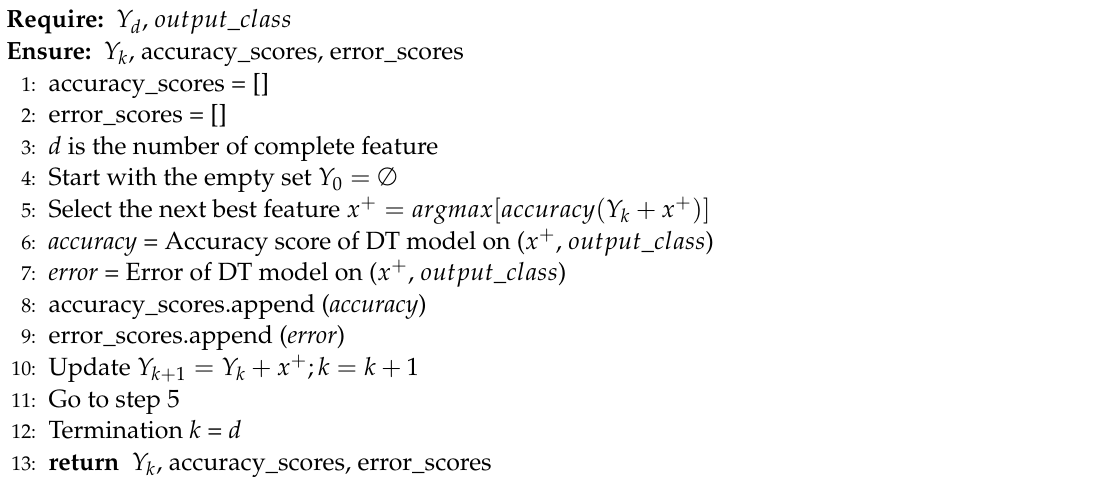
Algorithm 1 The pseudocode of the proposed SFSDT